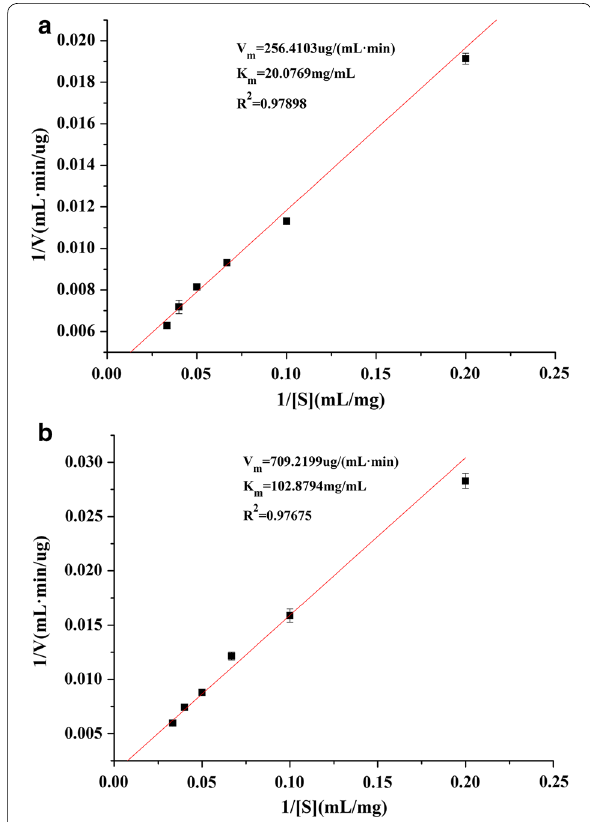
Table 2 Effect of different inhibitors and metal ions on the protease activity